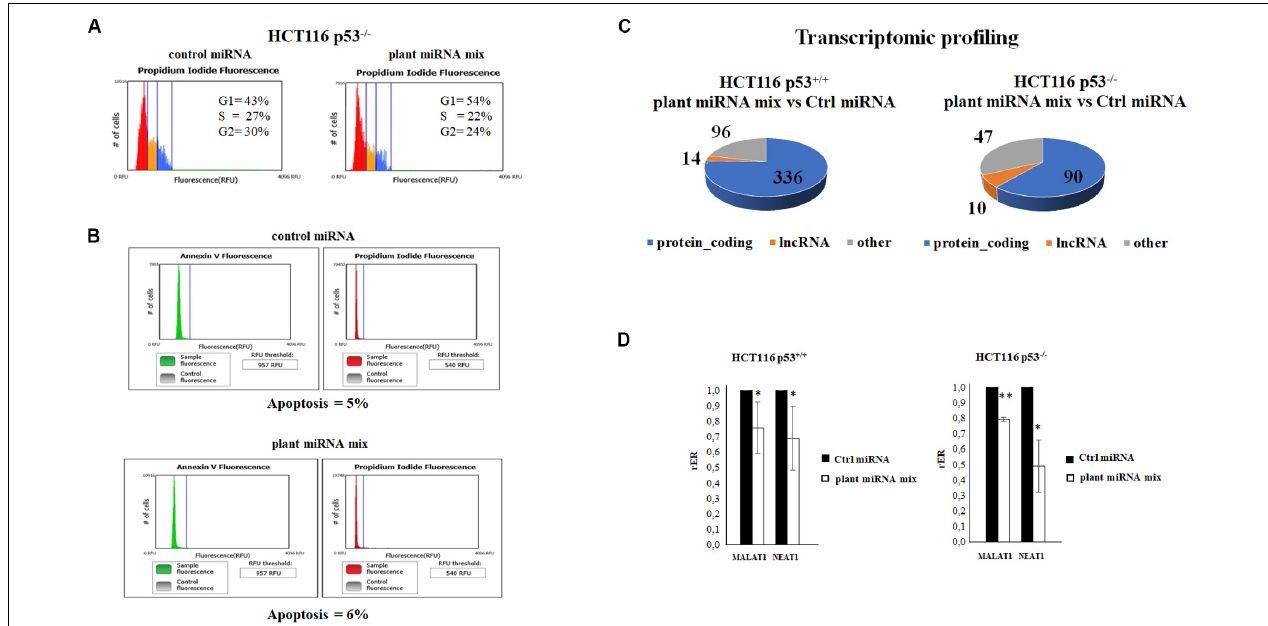
FIGURE 3 | Plant microRNAs (miRNAs) induce the arrest of the cells in G1 and modulate the transcriptomic profile. (A) Cell cycle analysis of HCT116p53 − / − transfected for 48 h with control miRNA or with a mix of the seven selected plant miRNAs (15 µ M f.c. for each; gma-miR-160, gma-miR-4995, gma-miR-4368, gma-miR-5677, gma-miR-4351, zma-miR-172, and mtr-miR-5754). (B) The apoptosis of HCT116 p53 − / − cell transfected with plant miRNA mix (15 µ M f.c. for each plant miRNA) or with the control miRNA was analyzed using Tali R (cid:13) Apoptosis Kit–Annexin V Alexa Fluor R (cid:13) 488 and propidium iodide. (C) The pie charts show the proportions of transcript types for statistically significant differentially expressed genes in HCT116 p53 + / + and HCT116 p53 − / − from RNA-Seq data analysis: protein coding, long non-coding RNAs (lncRNAs), others. (D) Reverse transcription quantitative PCR (RT-qPCR) of metastasis-associated lung adenocarcinoma transcript 1 (MALAT1) and nuclear paraspeckle assembly transcript 1 (NEAT1) lncRNAs in HCT116 p53 + / + and HCT116 p53 − / − cell lines transfected for 72 h with control miRNA or with a mix of the seven selected plant miRNAs (gma-miR-160, gma-miR-4995, gma-miR-4368, gma-miR-5677, gma-miR-4351, zma-miR-172, and mtr-miR-5754). Data are shown as the average with a standard deviation of three independent experiments (* p < 0.05 and ** p < 0.005).